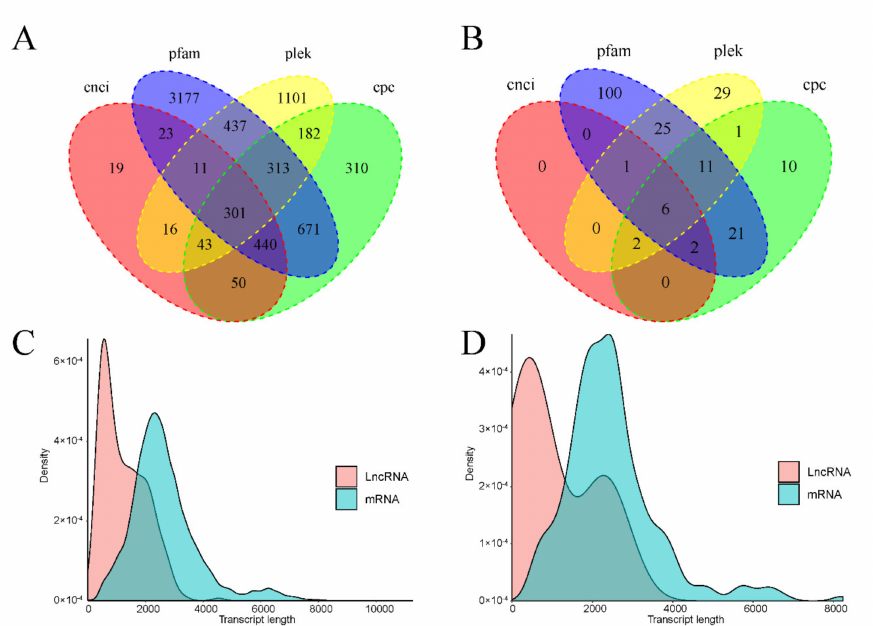
Figure 4. LncRNA analysis results of coral and zooxanthellae. ( A , B ) are LncRNA prediction Venn diagrams of coral and zooxanthellae, respectively. The sum of the numbers in each large circle represents the number of transcripts annotated by the database, and the part of the circle that overlaps represents the number of transcripts shared between the databases. ( C , D ) are the LncRNA and mRNA length distribution results of coral and zooxanthellae, respectively. The horizontal axis represents the transcript length and the vertical axis the